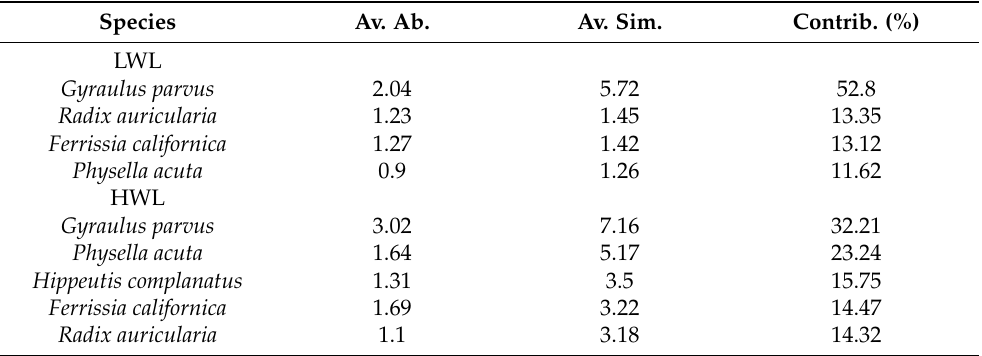
Table 2. Results of SIMPER analysis for gastropod assemblage during LWL and HWL of investigated waterbodies in S1 and S2 littoral benthal area. Av. Ab.—average abundance of specific species; Av.